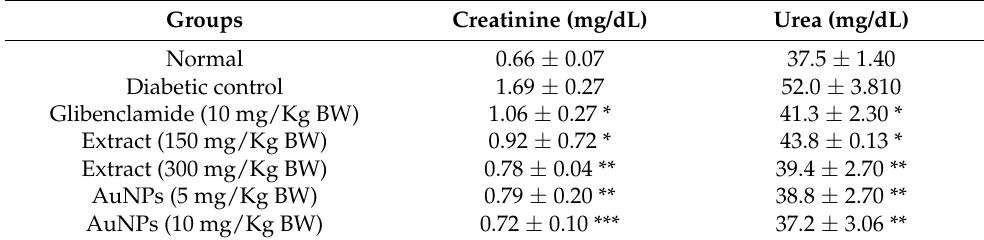
Table 12. Effect of a methanol extract and AuNPs on creatinine and urea in rat’s